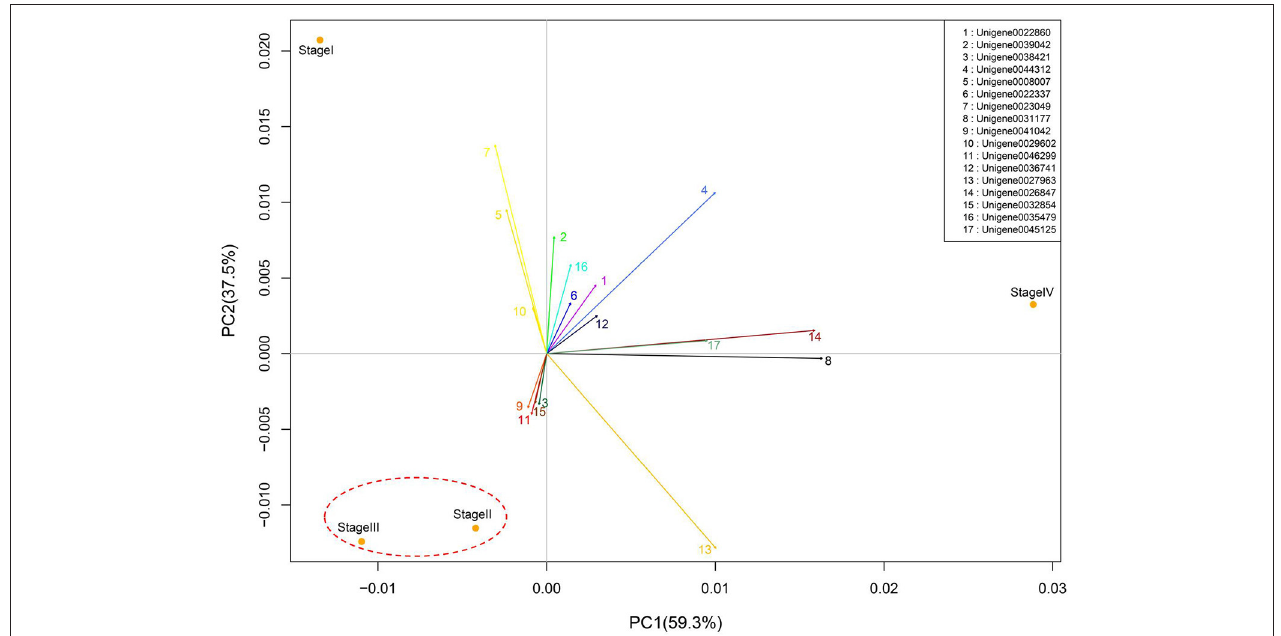
FIGURE 6 | Principal component analysis of bud stages based on the variation of global gene expression. The numbered lines projected from the origin of coordinates indicate major genes with highest PC scores.